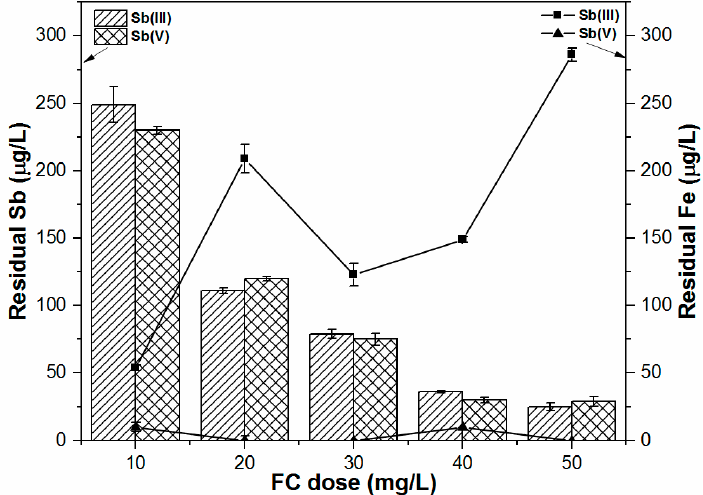
Figure 3. Effect of FC dose (10–50 mg/L) on the residual Fe concentration and Sb(III, V) removal efficiencies under neutral pH (7 ± 0.1), Sb(III, V) concentration (1 mg/L) and temperature (25 ± 1 °C).